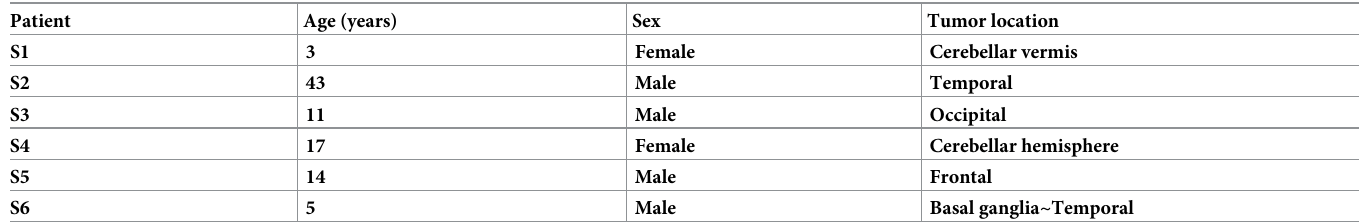
Table 1. Patient